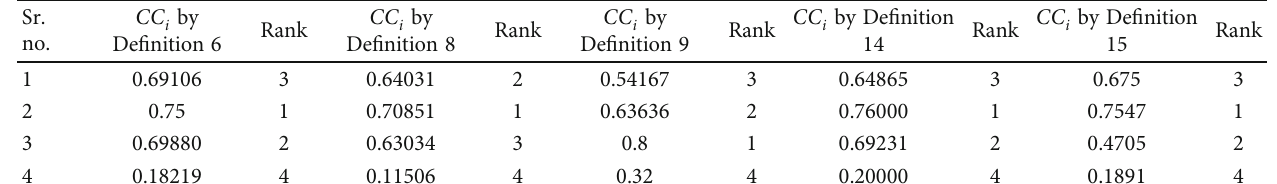
Table 6: Analyzed in comparison to the purposed distance